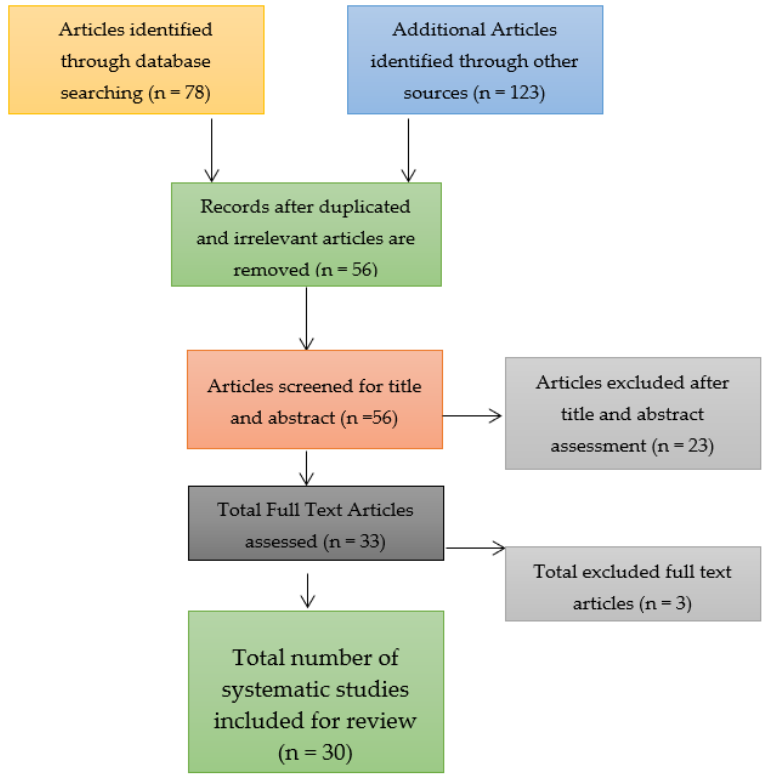
Figure 3. Study selection figure for the systematic review and